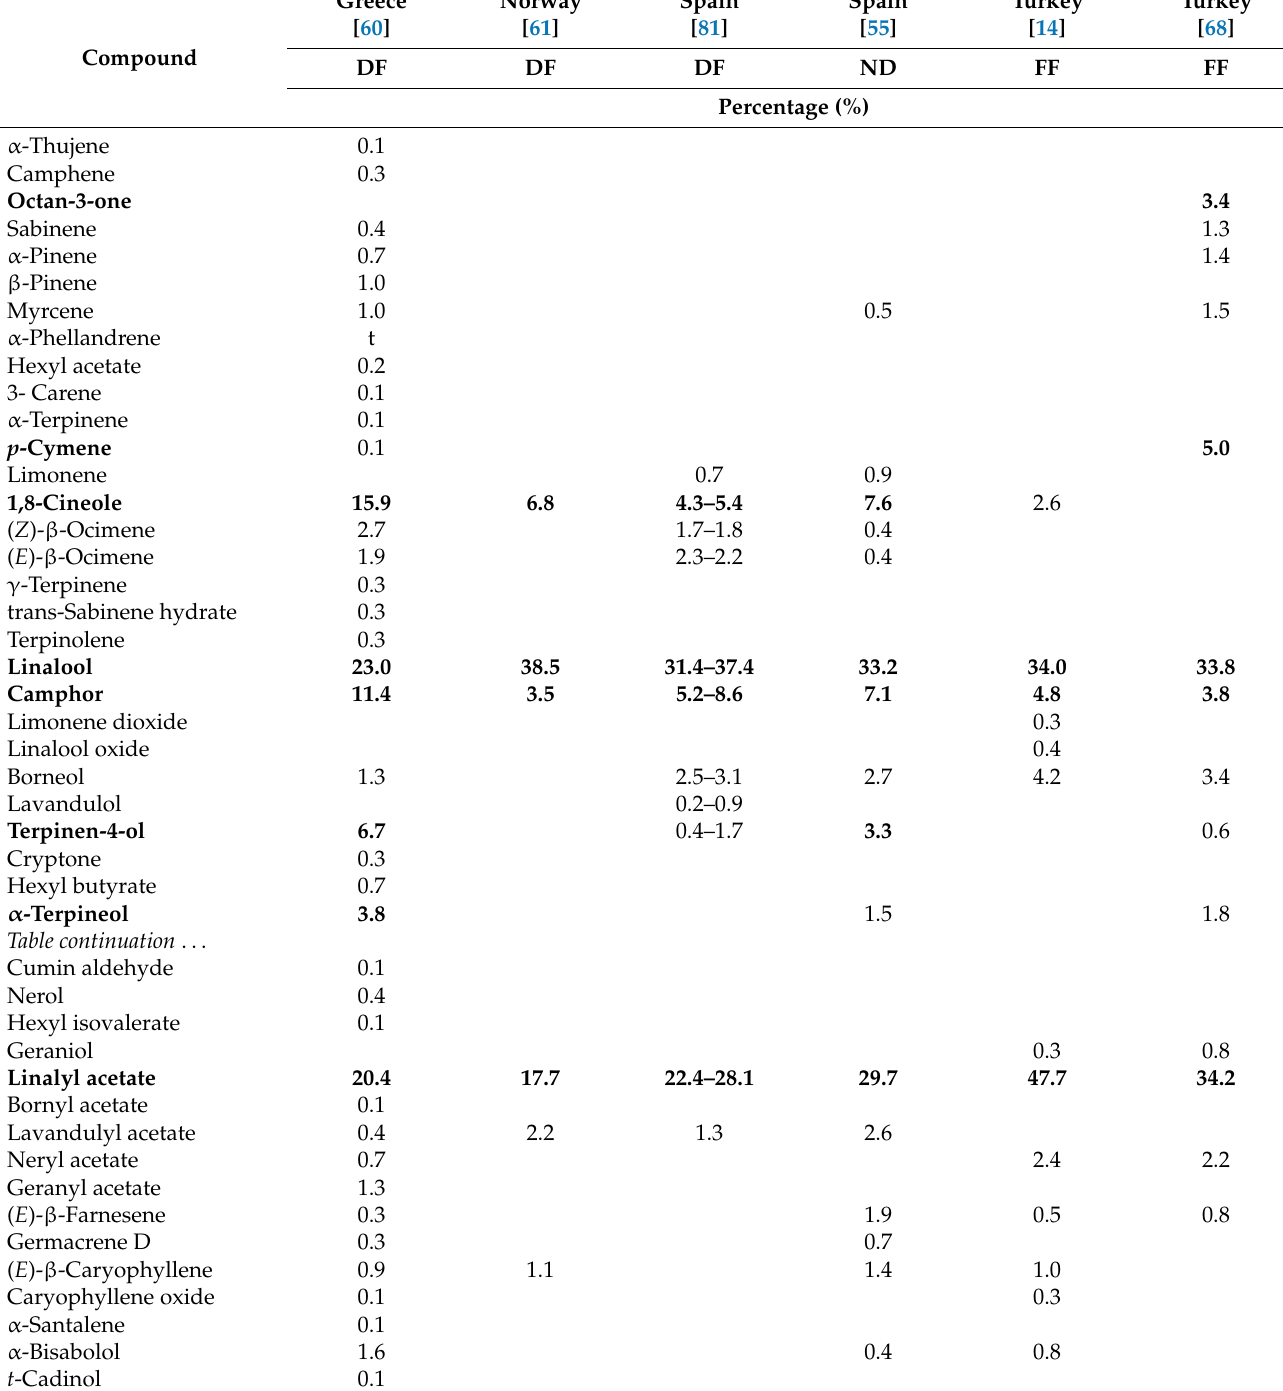
Table 5. Exemplary L. × intermedia ‘Super’ essential oil compositions from different countries. Values over 3% are bolded (this rule also applies to the following tables concerning chemical composition).